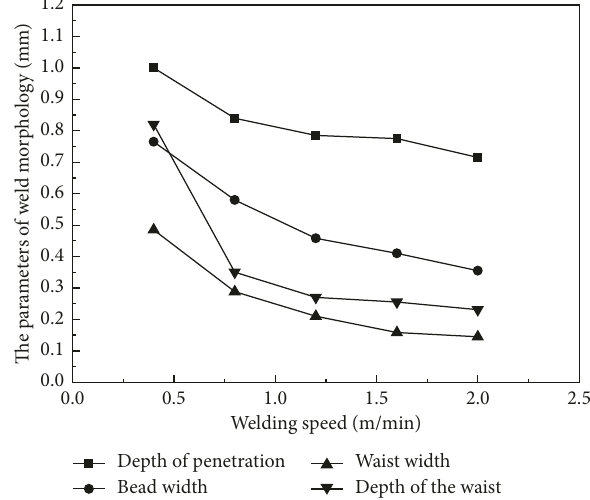
Figure 8: Effect of welding speed on the depth of penetration, bead width, waist width, and depth of the waist for the butt